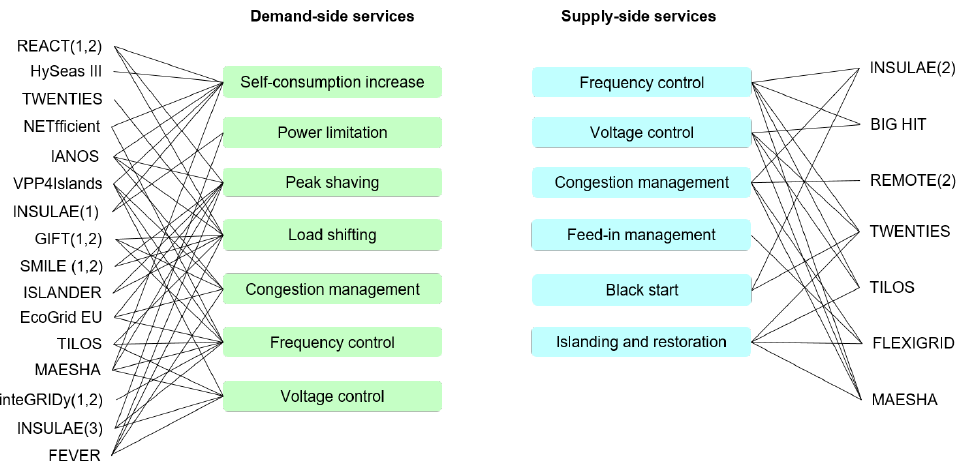
Figure 4. Services provided by the multi-energy